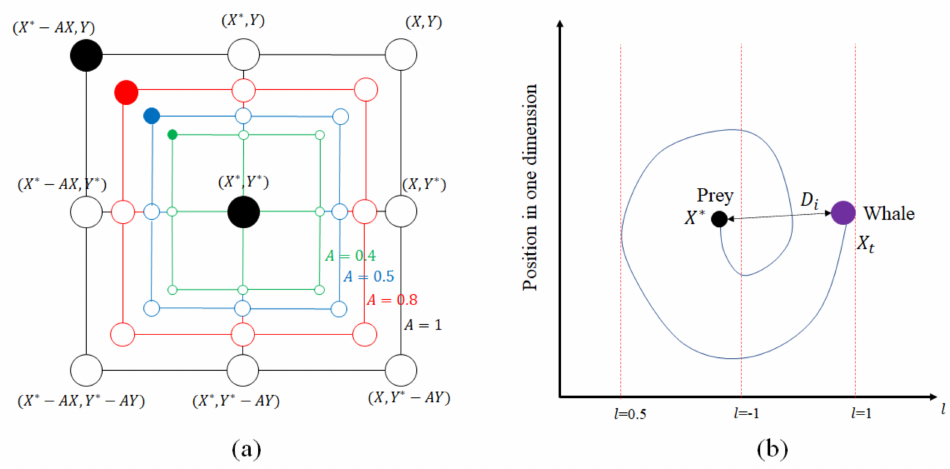
Figure 6. Search mechanism and whales’ movement in WOA: ( a ) shrinking encircling process; ( b ) position update in the spiral